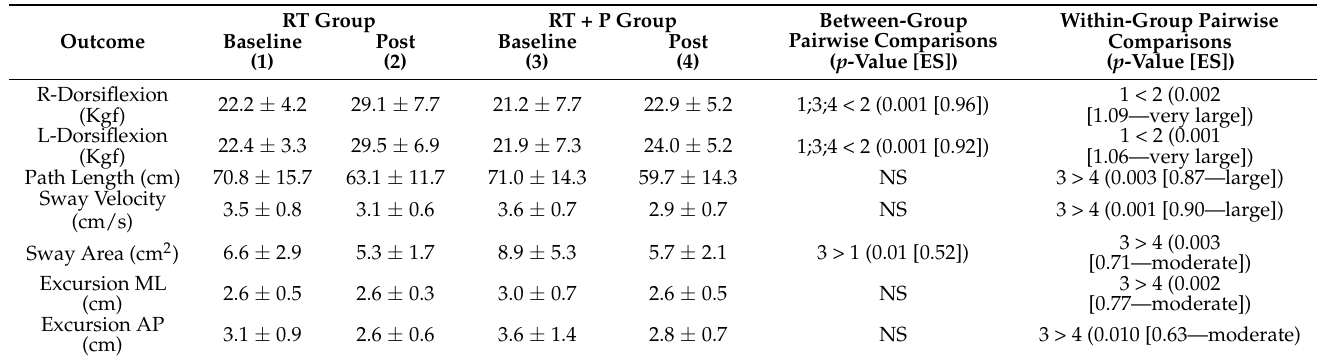
Table 2. Between-group and within-group pairwise